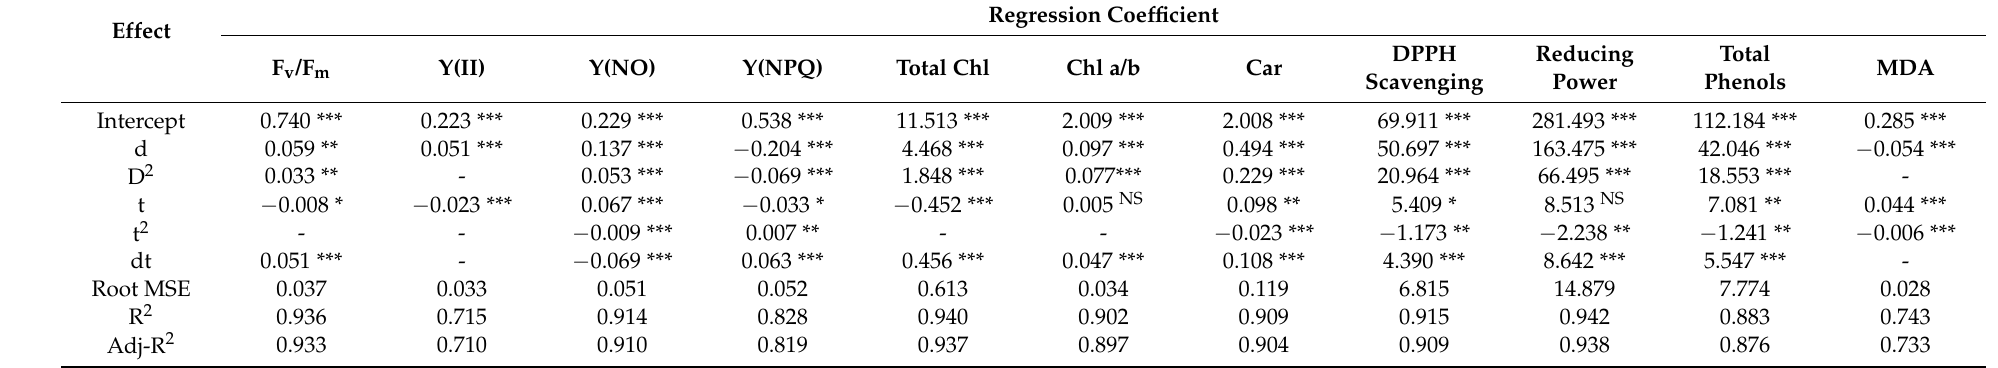
Table 1. Multiple regression models for F v /F m , Y(II), Y(NO), Y(NPQ), total chlorophyll (Chl), Chl a/b, Car, 1,1-diphenyl-2-picryl-hydrazyl (DPPH) radical scavenging capacity, MDA, total